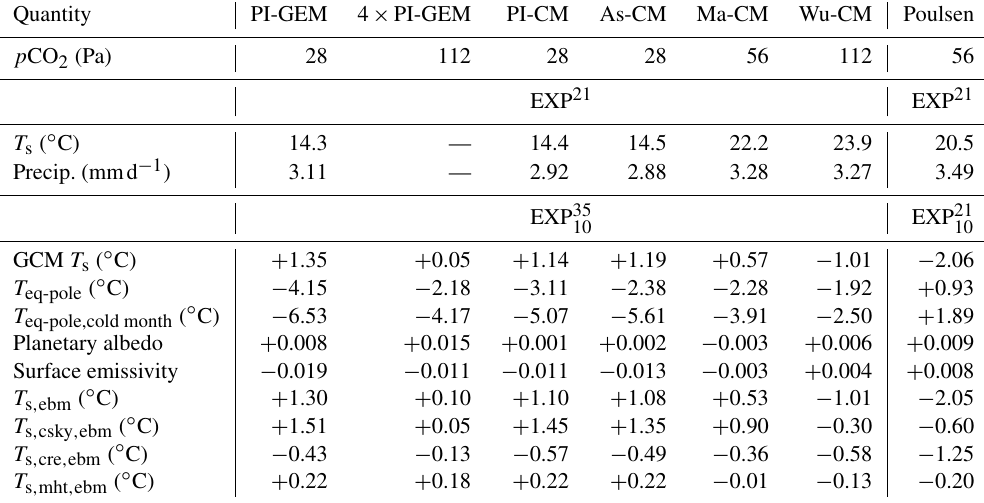
. Where applicable, results calculated for the Poulsen et al. (2015) Cenomanian 21%– Table 2. Summary of results for EXP 21 , then EXP 35 10 10% oxygen simulation are also presented. Abbreviations: T eq-pole (Equator-to-pole surface air temperature gradient), T eq-pole,cold month (Equator-to-pole surface air temperature gradient for cold months), EBM (quantities obtained using a Budyko–Sellers 1-D energy bal- ance model following Heinemann, 2009), T s , ebm (EBM surface temperature), T s , csky , ebm (EBM surface temperature change accounting